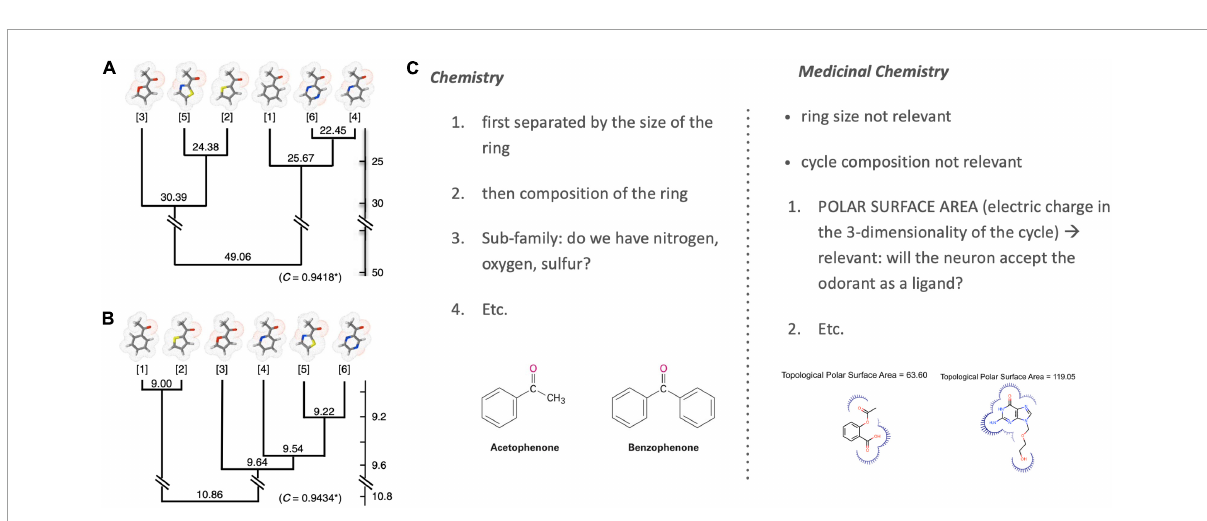
FIGURE5 Classification of odorant similarity according to analytic and medicinal chemistry. Illustrated is the difference between the classification of the chemical similarity of ketones (left) according to (A) the principles of analytic chemistry and (B) medicinal chemistry and receptor behavior [image from Poivet et al. (2016); OSN stands for Olfactory Sensory Neurons]. Differences are especially visible when comparing the closest similarity pairs in (A) analytic chemistry {4; 6} and (B) medicinal chemistry {1; 2}. These differences are grounded in varying ordering criteria of chemical similarity between chemistry and medicinal chemistry [example right; (C) ] [Note: Sample molecules in panel (C) are not ketones but chosen merely for an illustration of the selection